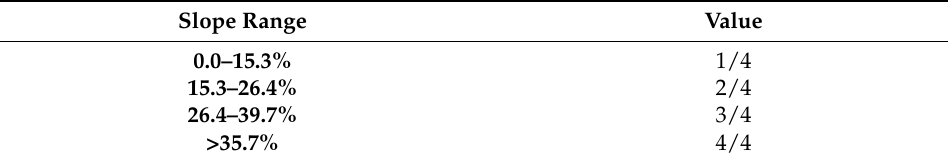
Table A11. Slope assigned values.